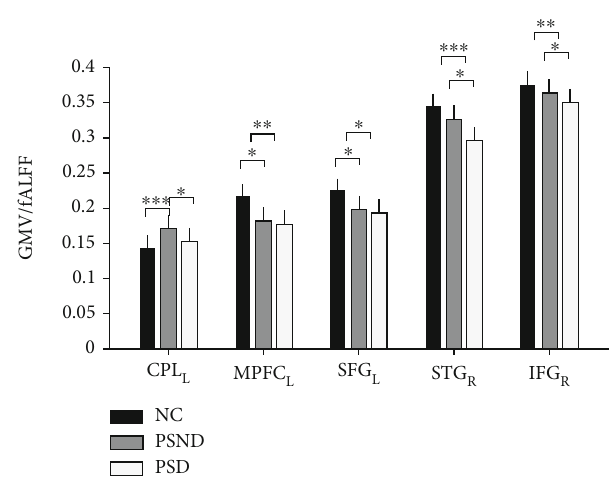
Figure 3: The di ff erences in GMV and fALFF values among the PSND, PSD, and NC groups. GMV: gray matter volume; fALFF: fractional amplitude of low-frequency fl uctuation; CPL_L: left cerebellum posterior lobe; mPFC_L: left medial prefrontal cortex; SFG_L: left superior frontal gyrus; STG_R: right superior temporal gyrus; IFG_R: right inferior frontal gyrus. ∗ , ∗∗ , and ∗∗ ∗ represent p < 0 : 05 , p < 0 : 01 , and p < 0 : 001 ,